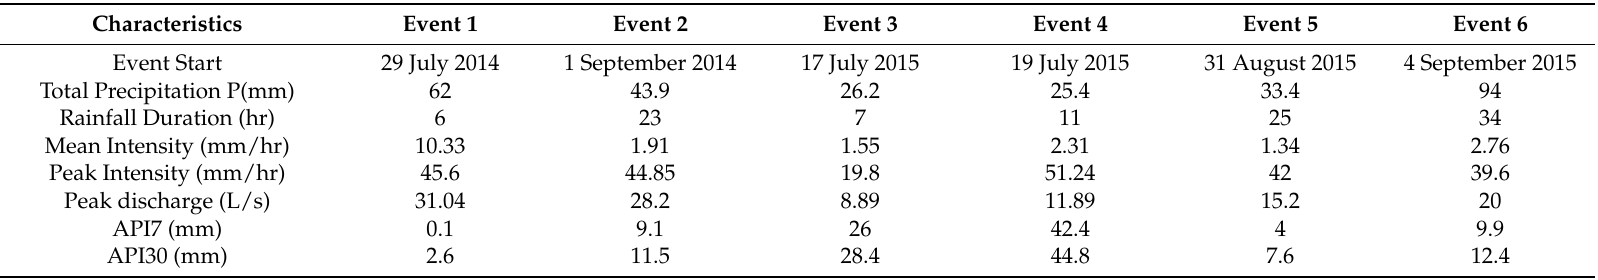
Figure 2. Three hillslope profiles of wells and bedrock structure based on core experiment, solid line represents observed groundwater table, dash line represents inferred groundwater table based on observed groundwater table. Table 1. Summary of rainfall and storm runoff characteristics of 6 storm events during summer of 2014 and 2015. API represents Antecedent Precipitation Index, API (n) is the sum of antecedent precipitation index over n days, calculated as: 𝐀𝐏𝐈 (cid:4666)𝐧(cid:4667) = ∑ 𝑷 𝒊 𝒊𝒏 𝒊(cid:2880)𝟏 , where i is the day count and P i is the daily precipitation previously.